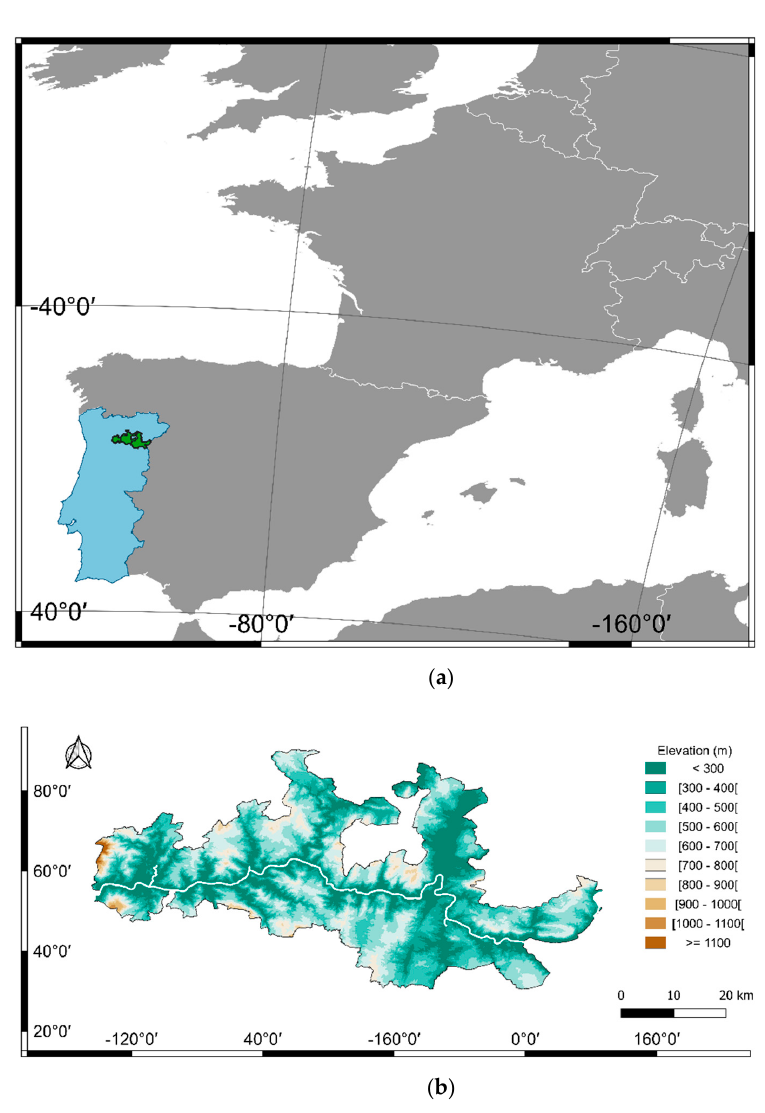
Figure 1. ( a ) Geographical location of the Douro Wine Region (DWR) in Europe and Portugal. ( b ) Hypsometric chart of the DWR (elevation in m). The coordinate system of the used projections is WGS 84.